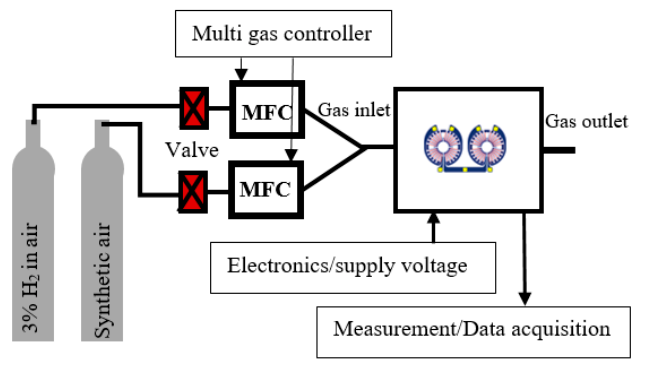
Figure 4. Schematic of the gas measurement setup.